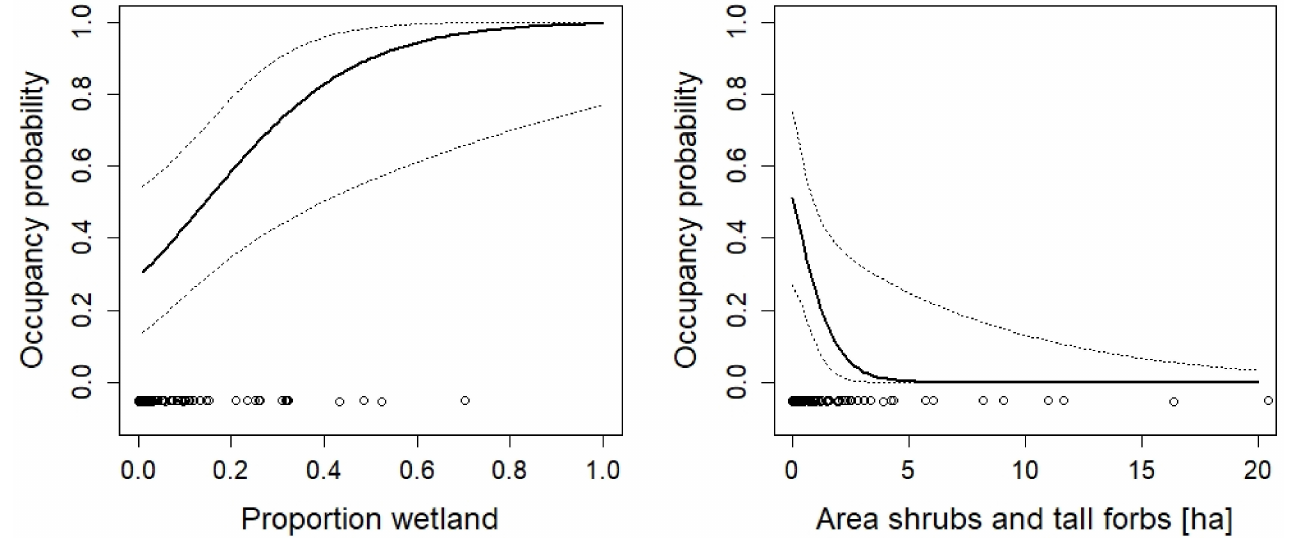
Figure 7. The effect of the proportion of wetlands and the area of shrubs and tall forbs on the occupancy probability of Lissotriton vulgaris . For additional explanations, see the caption of Figure 2.